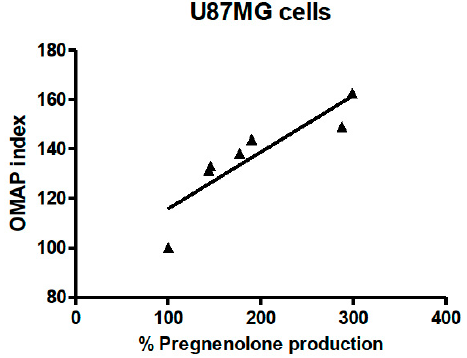
Figure 3. Spearman’s correlation analyses of the Oxidative Metabolism Activity/Proliferation (OMAP) index and pregnenolone production in U87MG cells. The percentages of pregnenolone production obtained in the steroidogenesis experiments (U87MG cells were exposed to 40 µ M PIGA ligand in saline medium for 2 h) were correlated to the OMAP indexes obtained in the metabolic experiments (U87MG cells were exposed to 1 µ M PIGA ligand in serum-reduced medium for 48 h). The statistical analyses were performed using the Spearman r correlation, reporting a p < 0.001.